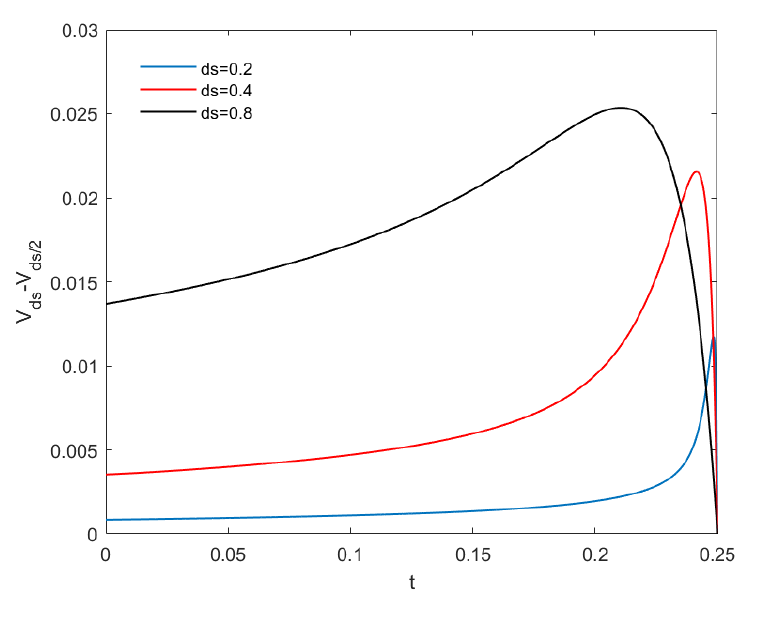
Figure 5. Difference V ds − V ds /2 . Table 2. Convergency results for the linear model.